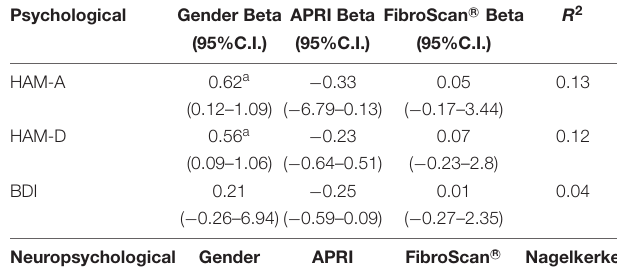
TABLE 4 | Association between gender, psychological and categorized neuropsychological results, controlling for disease severity.